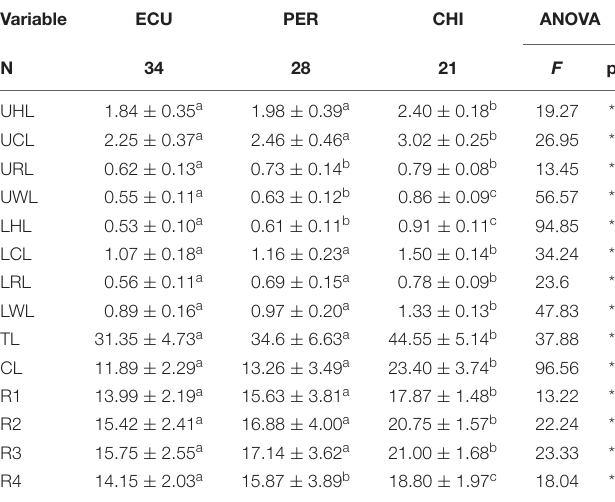
TABLE 2 | Summary information of feeding apparatuses morphometric measurements (cm) of Dosidicus gigas relative to three geographic stocks.